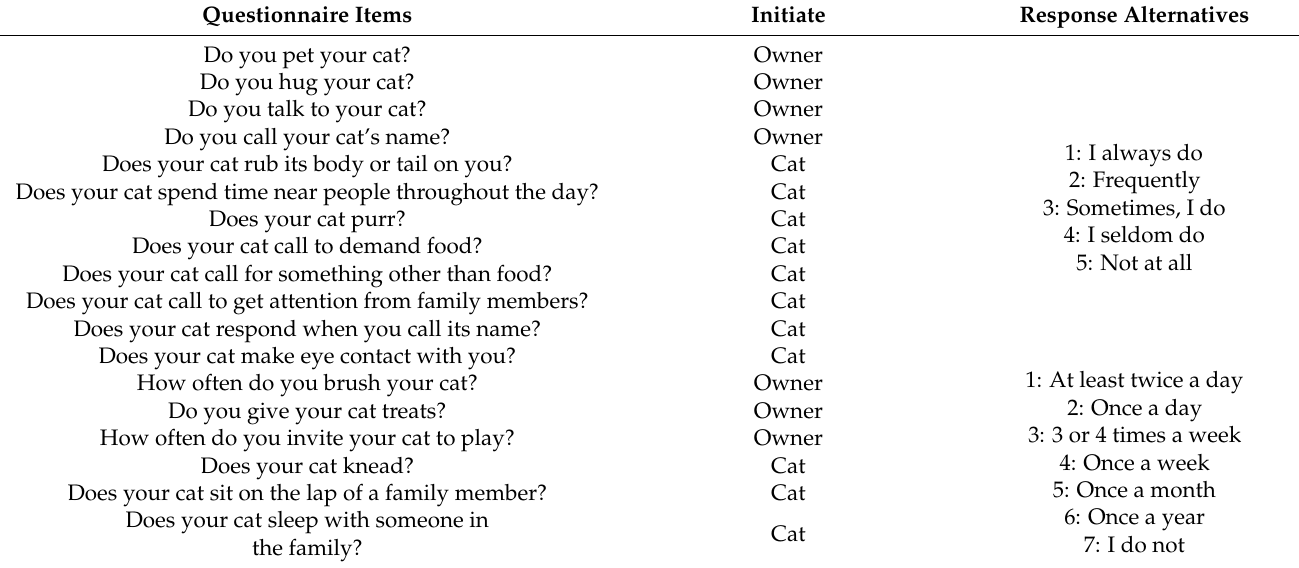
Table 1. List of questionnaire items and response